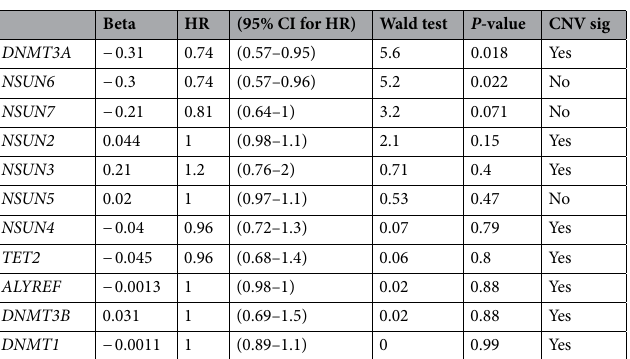
Table 2. Univariate Cox regression exploring the relationship between different m5C regulatory gene expression levels and patient